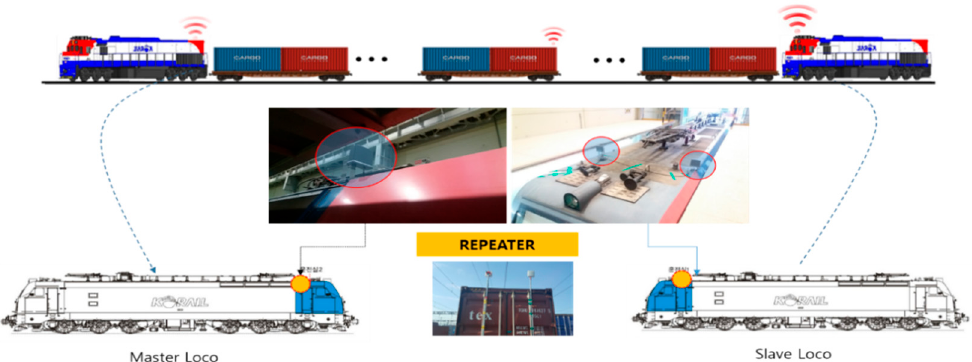
Figure 3. WDPS configuration and antenna installation.